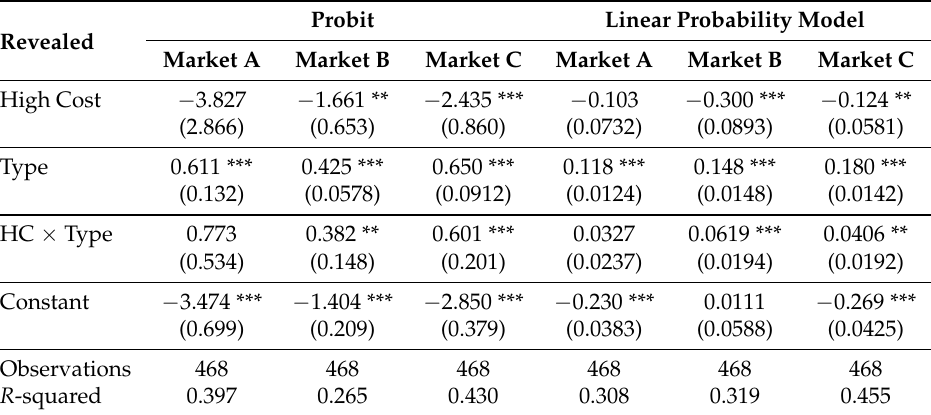
Table 2. Probit regressions and linear probability models as robustness check. Note: the standard errors presented in the table are clustered at the subjects-level. Clustering at the group or session-level does not change the results qualitatively. In such regressions, all the effects identified are significant at the 1%